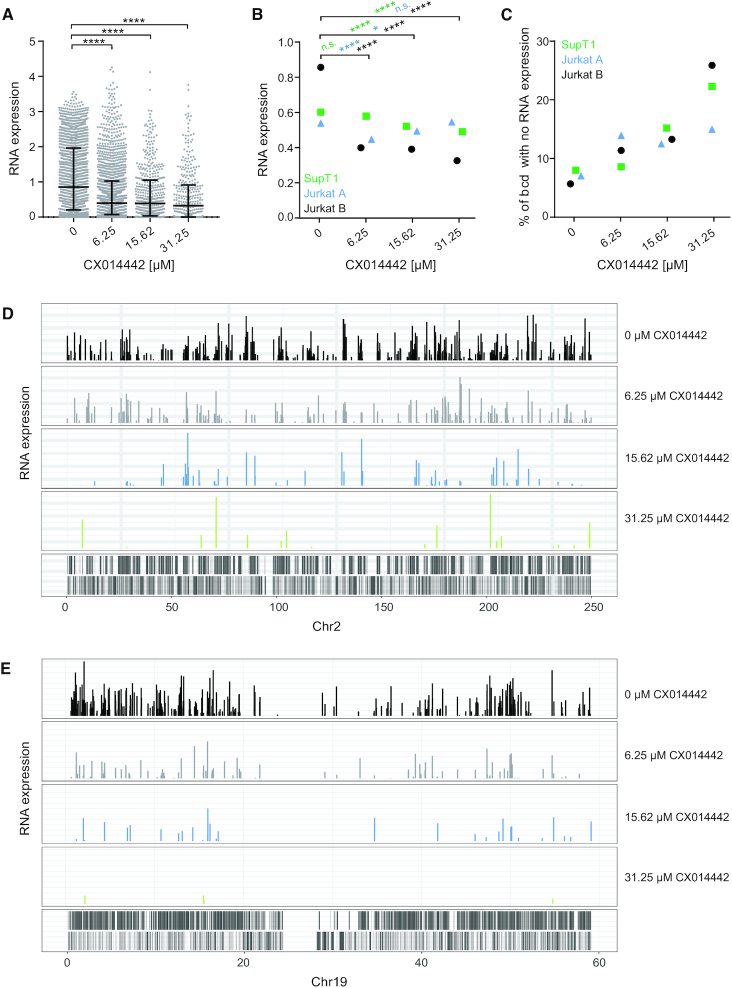
LEDGIN treatment reduces RNA expression. Two weeks post transduction in the presence of varying concentrations of LEDGIN CX014442, mRNA was extracted and reverse transcribed to cDNA to determine RNA expression. (A) Expression in Jurkat cells (experiment B) was determined using the B-HIVE method. The expression score is calculated for each unique barcode (dot) by normalizing the barcode counts in the RNA to the corresponding DNA counts. Error bars represent median and interquartile range. (B) Median RNA expression scores for two independent experiments in Jurkat cells (experiment A and B) and one in SupT cells (experiment A). (C) The percentage of DNA barcodes that did not show RNA expression was calculated relative to the total number of barcodes found in each condition in SupT1 and Jurkat cells. (D) Expression landscape of barcodes integrated in chromosome 2. Each bar represents an integration site and the height of the bar corresponds to the expression level. (E) Expression landscape of barcodes integrated in chromosome 19. Statistical significance was calculated by the Kruskal–Wallis test, **** P< 0.0001, *P< 0.05.